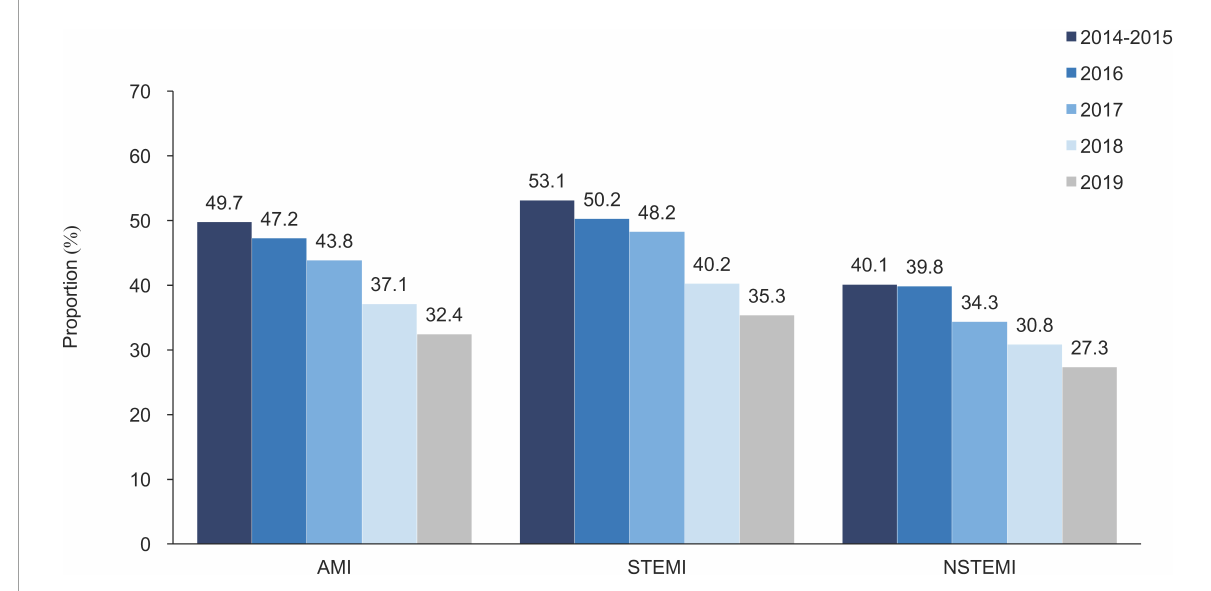
FIGURE2 Proportion of inter-hospital transfer in patients with AMI, by the year of admission. AMI, acute myocardial infarction; NSTEMI, non-ST-segment elevation myocardial infarction; and STEMI, ST-segment elevation myocardial infarction.